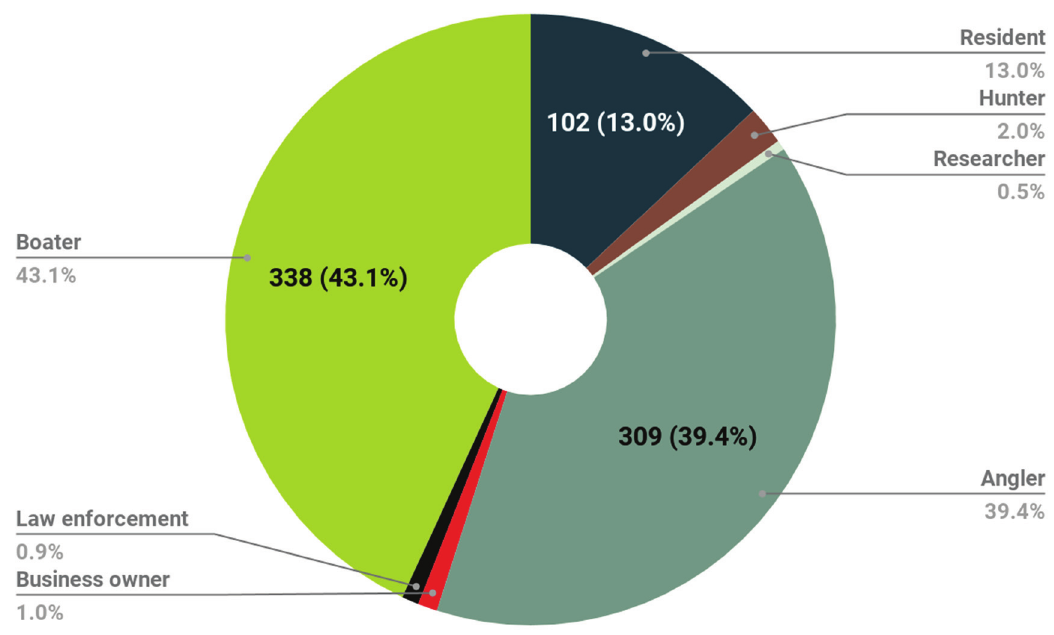
Figure 5. Which user category do you identify with most?